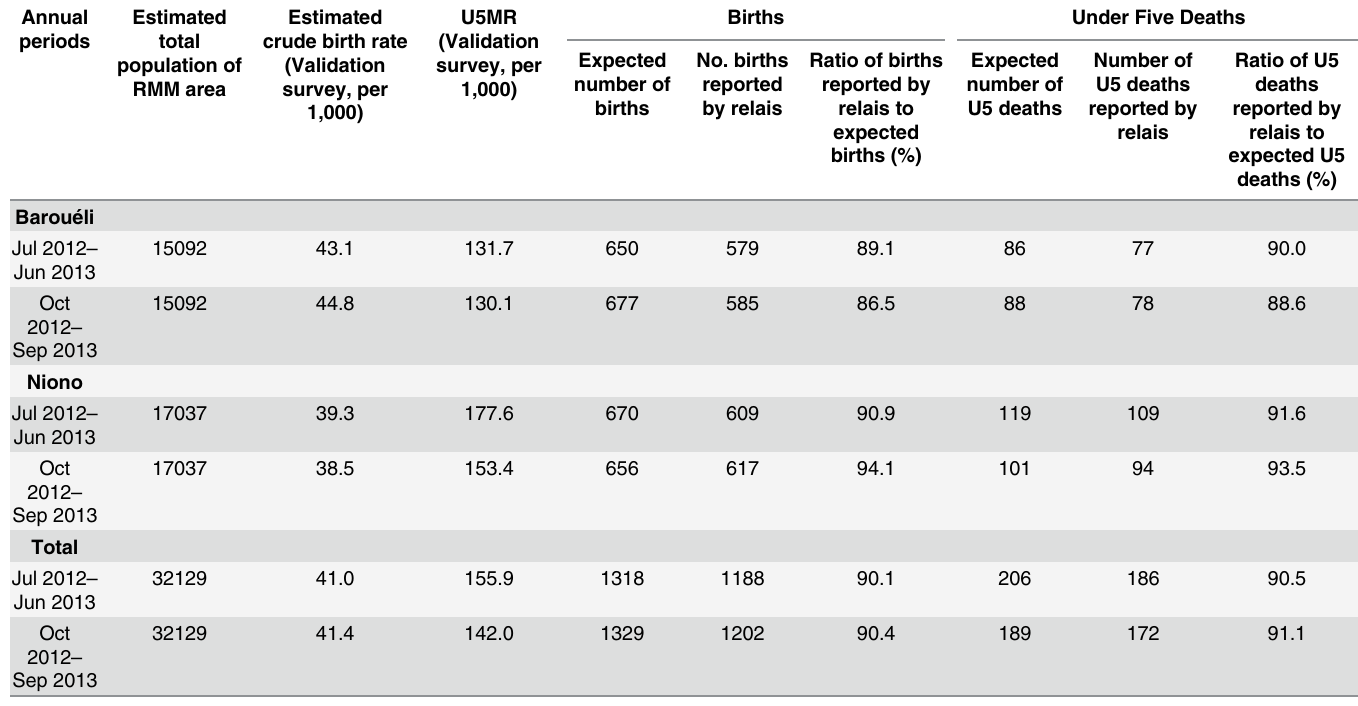
Table 2. Births and under-five deaths reported by relais compared to expected births and deaths based on validation survey.